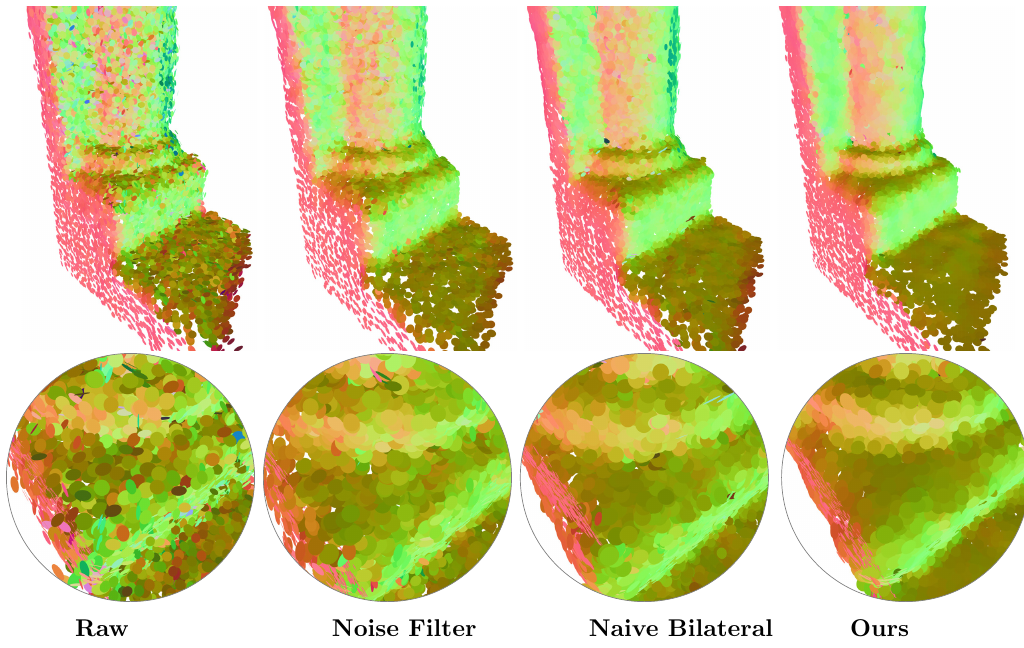
Raw Noise Filter Naive Bilateral Ours Figure 4. Comparison of denoising results by using CloudCompare (v.2.11, 2021) noise filter, naive bilateral filter (Digne and De Franchis, 2017), and our approach. Points are colored by their